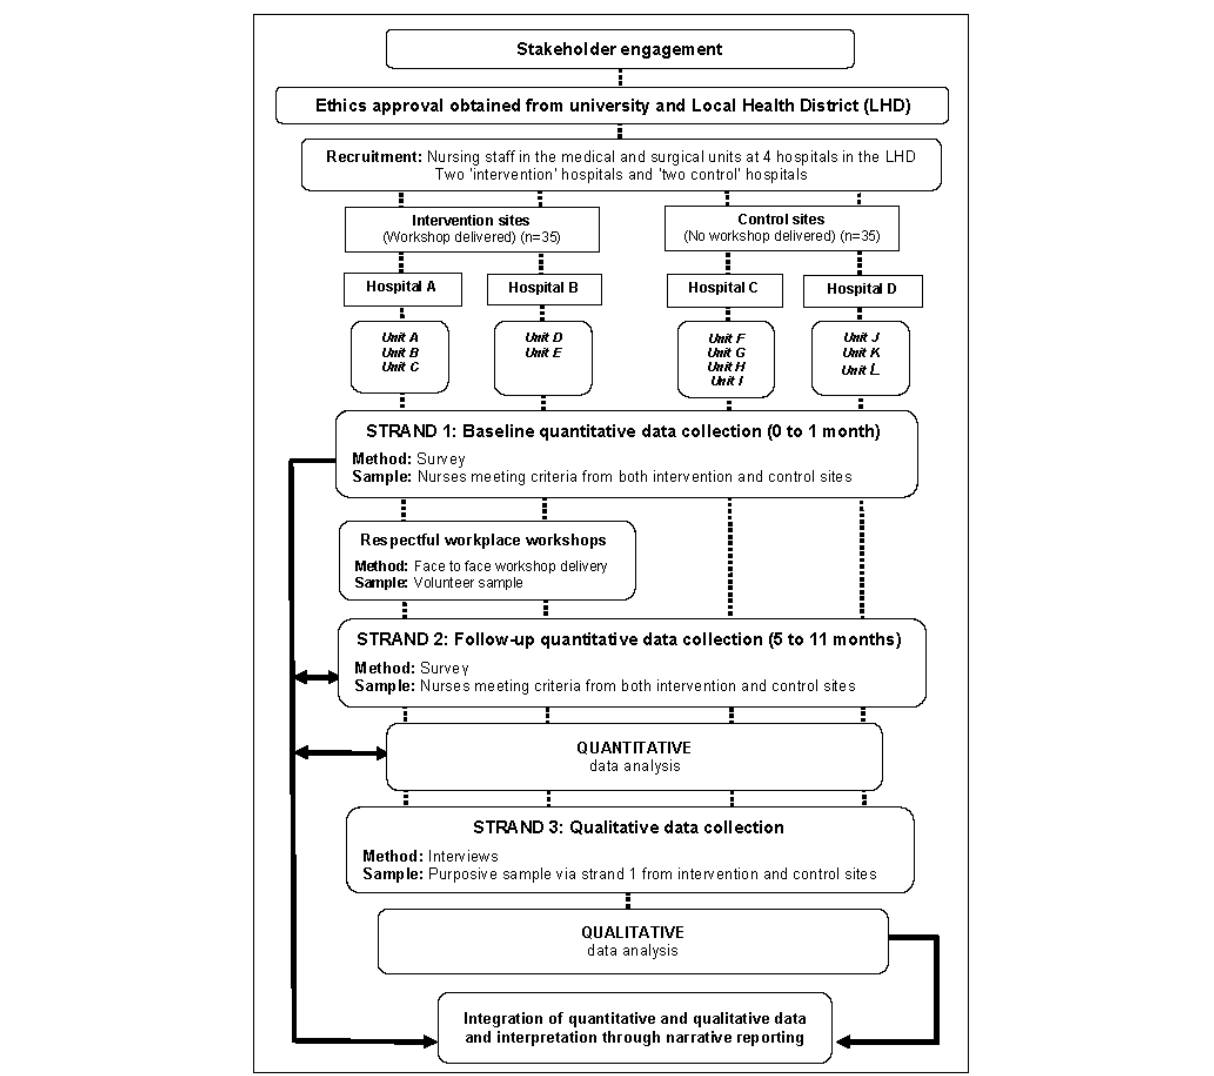
Figure 1. Flowchart showing the entire research process for the mixed methods